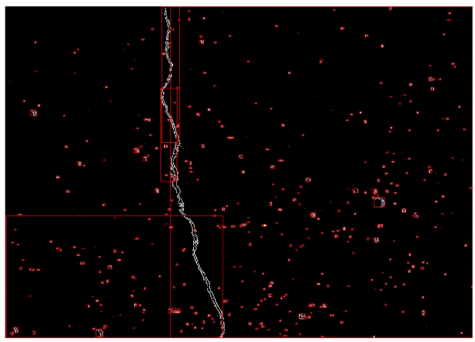
Figure 6. Image after labelling connected fields.